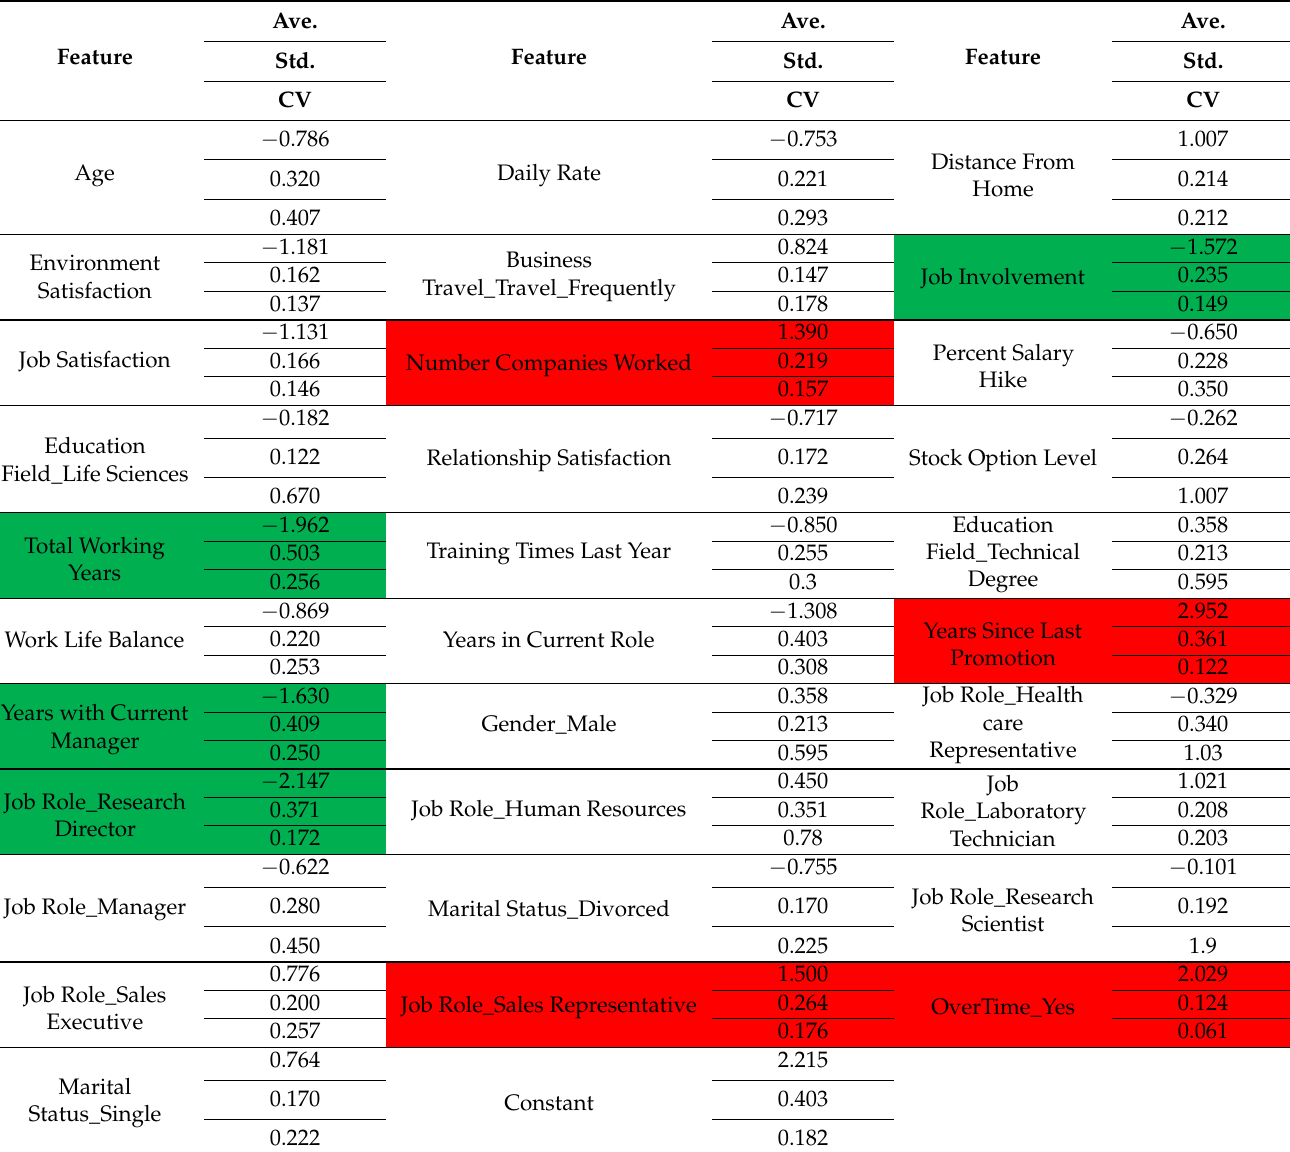
Table 4. Variation of Coefficients Across 300 Bootstrap Datasets. Green cells are the most important features that contribute to staying with the company and red cells are the features that contribute most to leaving the company. Ave. Ave. Ave. Feature Feature Feature Std. Std.